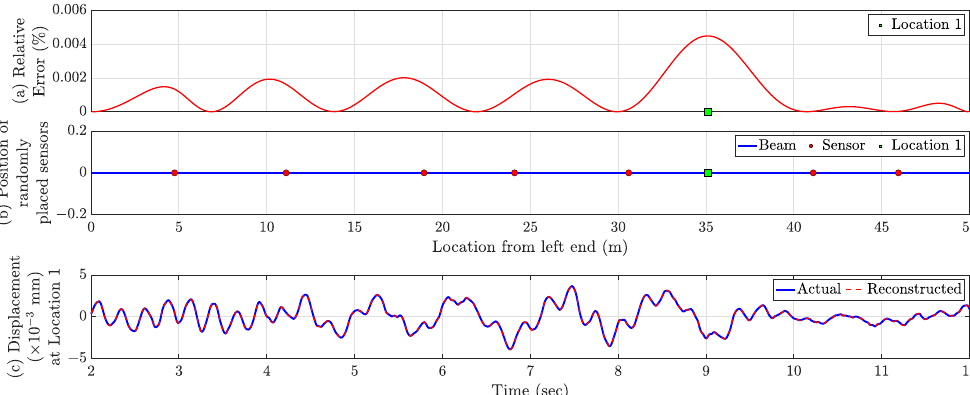
Figure 6. ( a ) Relative Errors ( (cid:101) i ) in % for the virtual dense sensing points with the optimal number of sensors placed in a stratified random fashion. The ‘green square’ marker represents the location of maximum relative error. ( b ) Location of actual sensors (shown as ‘red circles’). ( c ) Comparison of actual and reconstructed time history response at Location